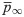
Variation of the long-term fraction p¯∞ of cooperators with average degree k and cost-to-benefit ratio ρ, in the snowdrift game on model networks.(a)-(c) random regular networks; (d)-(f) exponential networks; and (g)-(i) scale-free networks. (a)(d)(g) p¯∞ versus k and ρ. (b)(e)(h) p¯∞ versus k when ρ = 0.75. The dashed lines show the asymptotic frequency of cooperators in a well-mixed population. (d)(f)(i) p¯∞ versus ρ when k = 4. The dashed lines show the asymptotic frequency of cooperators in a well-mixed population.